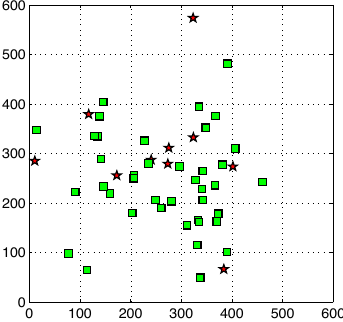
Figure 4: An example of the synthetic image data. The green squares are the inliers, the red stars are the outliers.